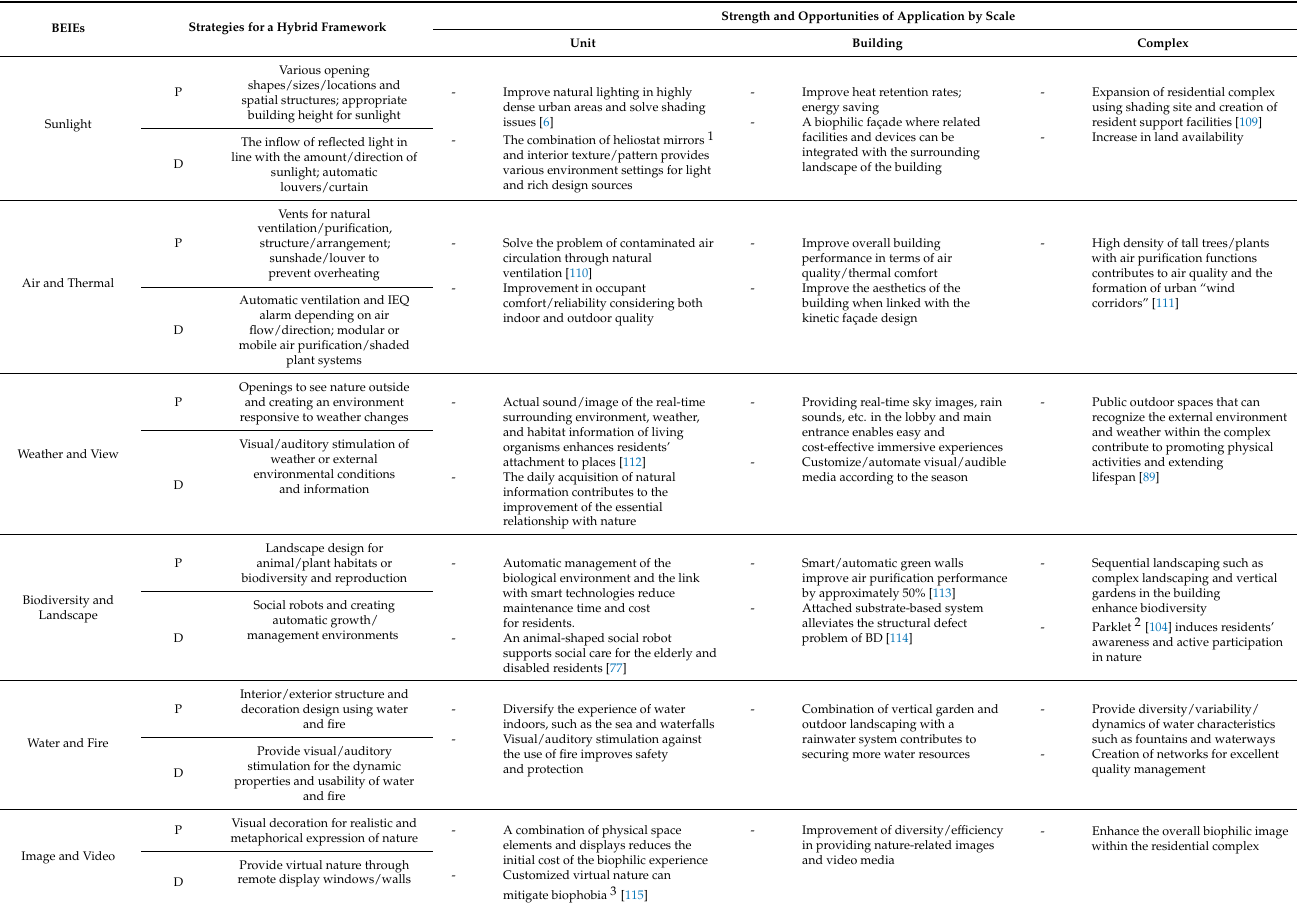
Table 5. Strategies of a residential hybrid framework for biophilic experience by